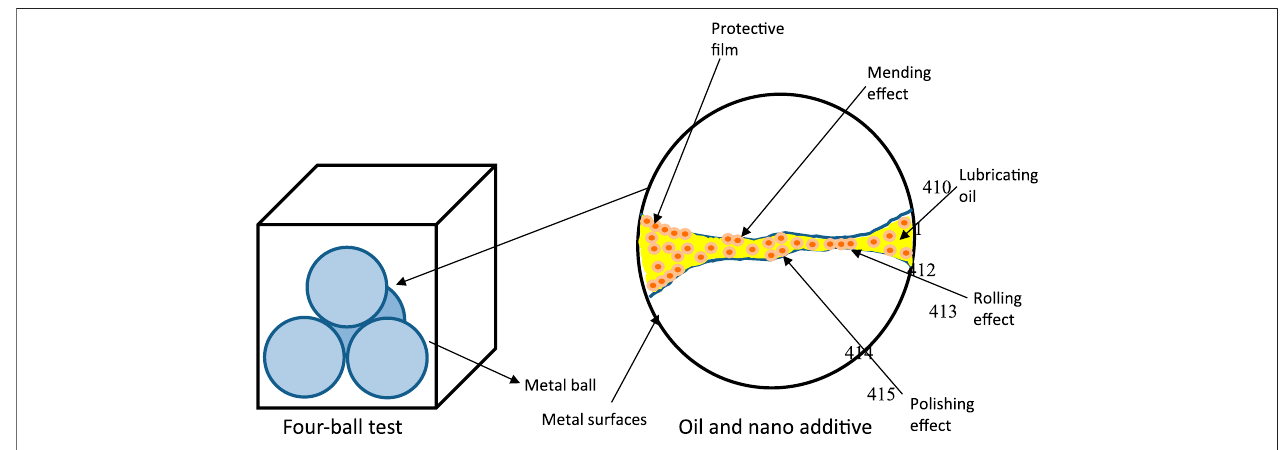
FIGURE 5 | Mechanism of nano additive between contacting surfaces (Sha fi et al.,